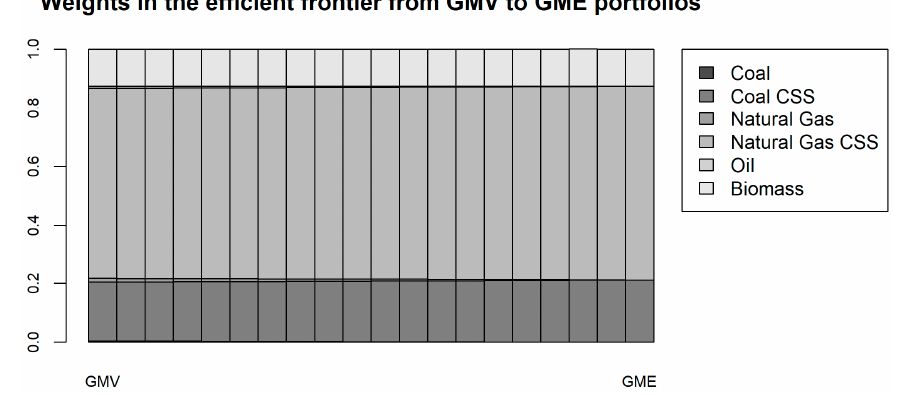
Figure 6. Model adaptation with technological constraints.